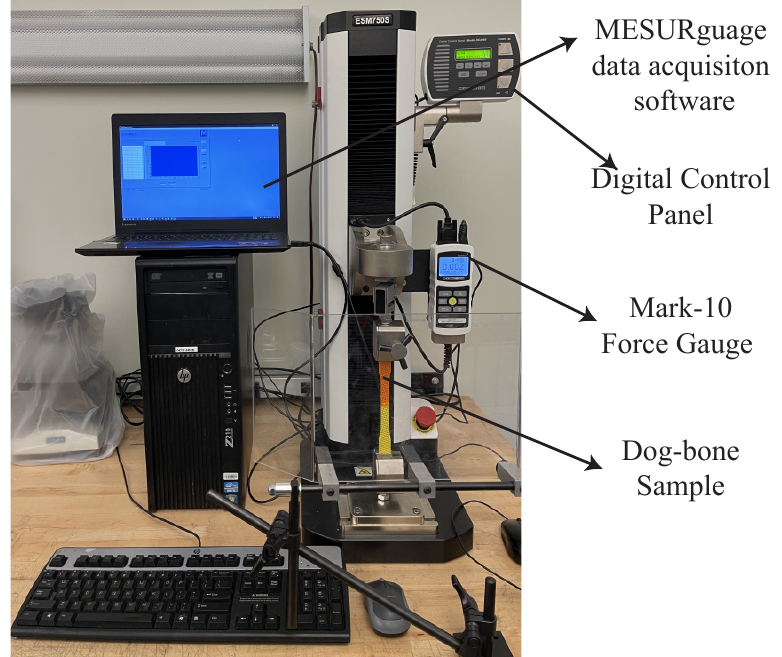
Figure 10. The experimental setup for tensile test.